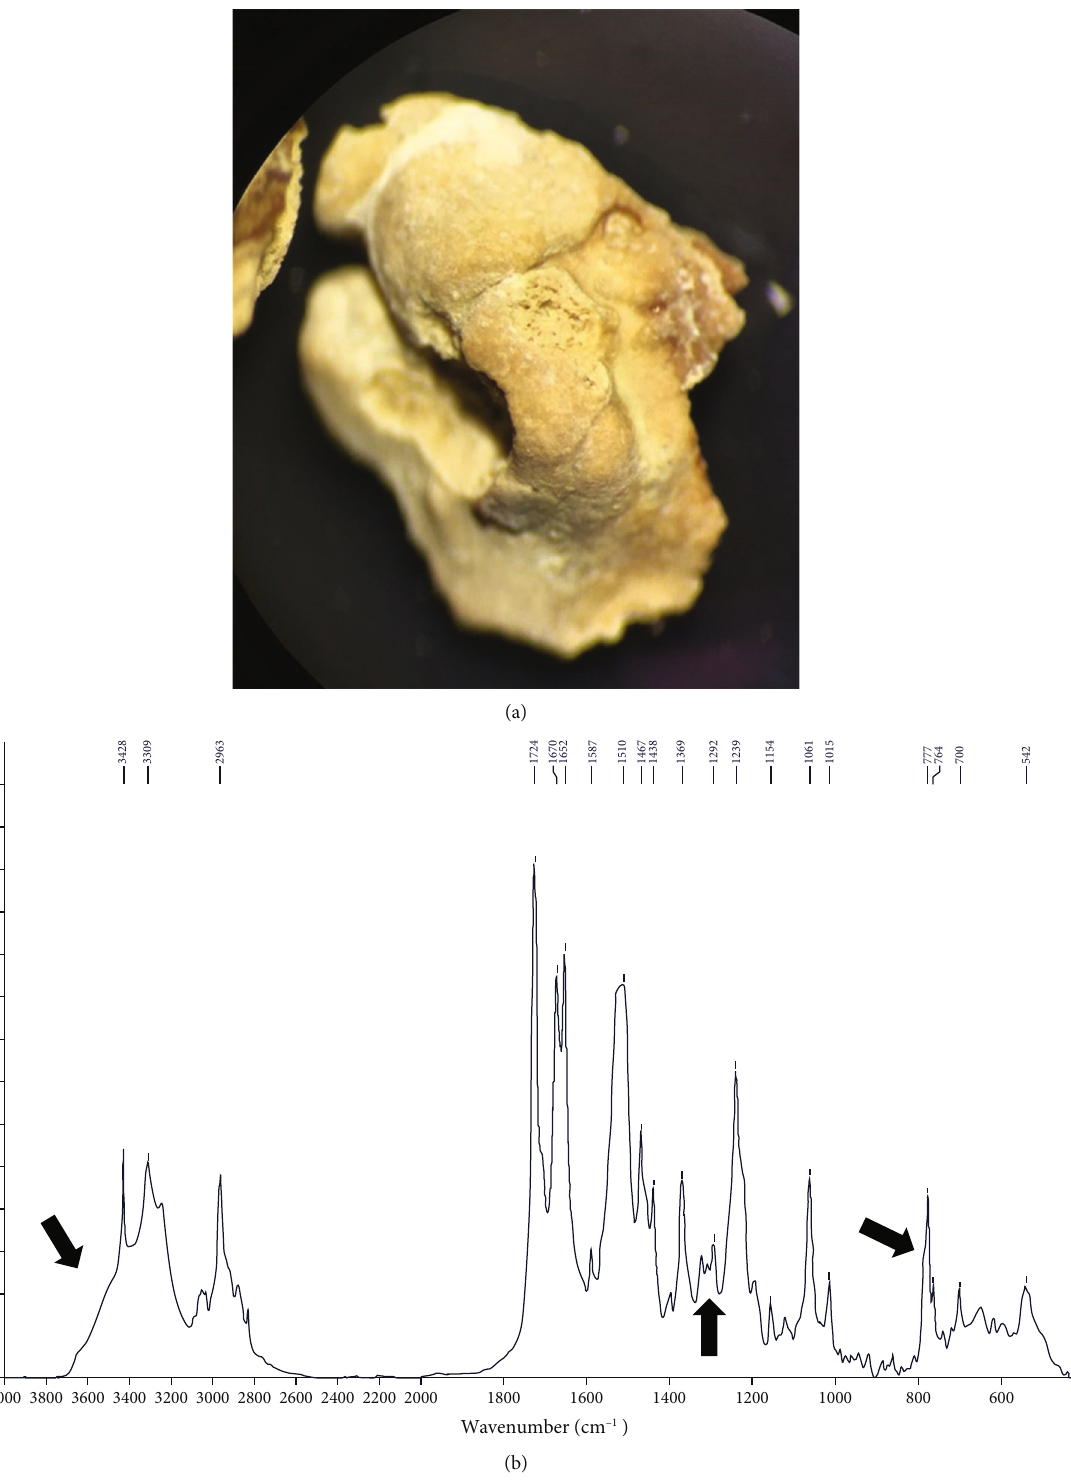
Figure 2: (a) Morphological analysis showed unusual fragments, yellowish in color, fi nely rough, and friable. Cross-section was relatively well organized, with porous structure and radial crystallization locations. (b) Infrared spectrum of atazanavir, C1, and proteins observed after crushing the stone and FTIR spectroscopy analysis (Bruker Optics, Germany). Arrows indicate places where C1 is identi fi able in the main spectrum of